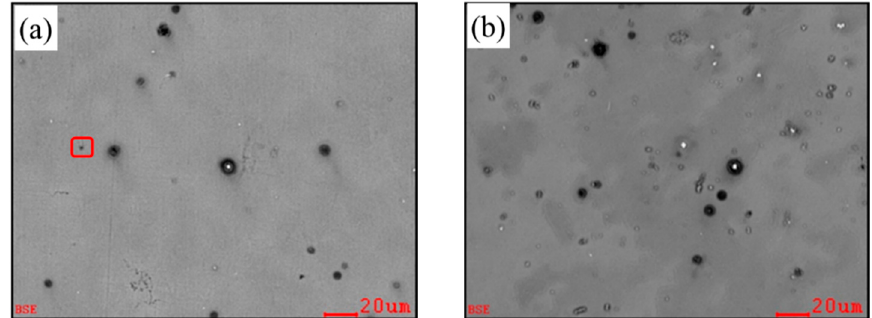
Figure 2. Electron probe microanalyzer (EPMA)-back-scattered electron (BSE) micrographs of the 0.05%Fe containing Mg-3%Al alloy refined by carbon inoculation ( a ) and carbon inoculation combined with the addition of 0.2%Ca ( b ).